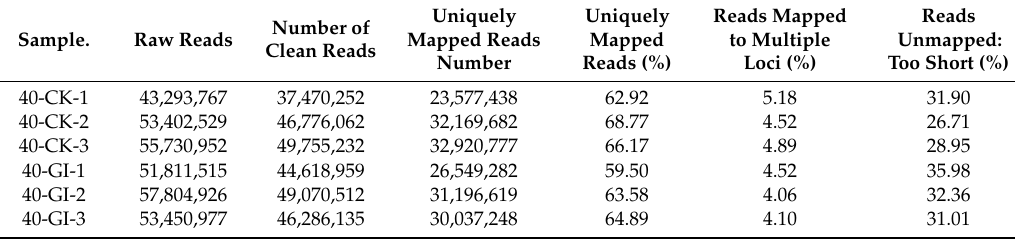
Table 1. Statistics of RNA-Seq read mapping results.